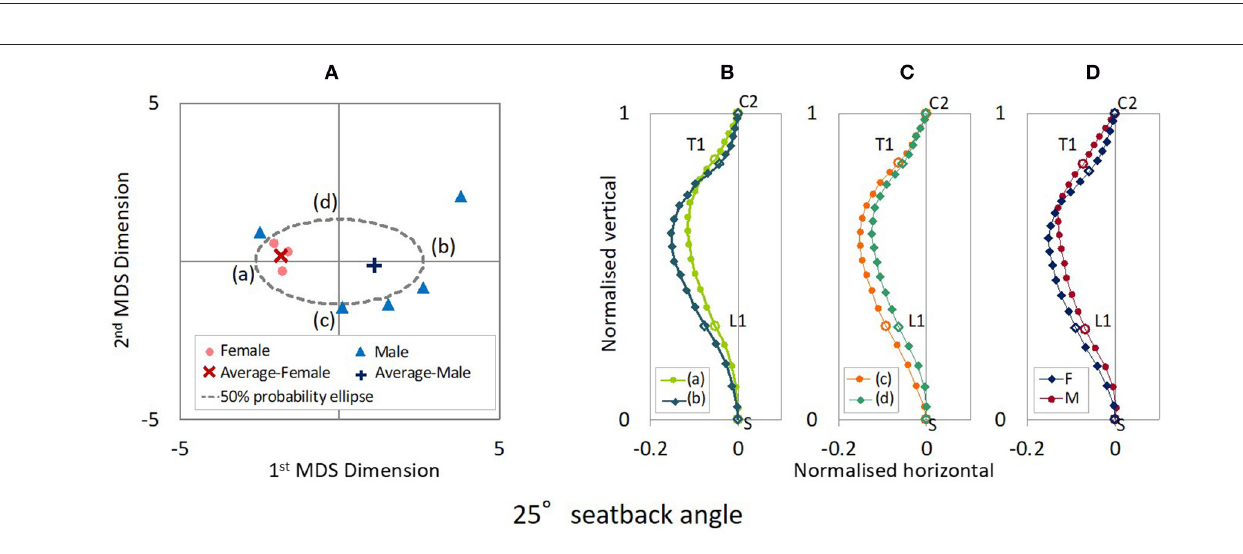
Figure 3D . On the distribution map, the average MDS point was located on the left side against the origin for female subjects and the right side for male subjects along the first MDS dimension, while the average MDS score of the second MDS dimension was close to zero for both genders. Hence, the